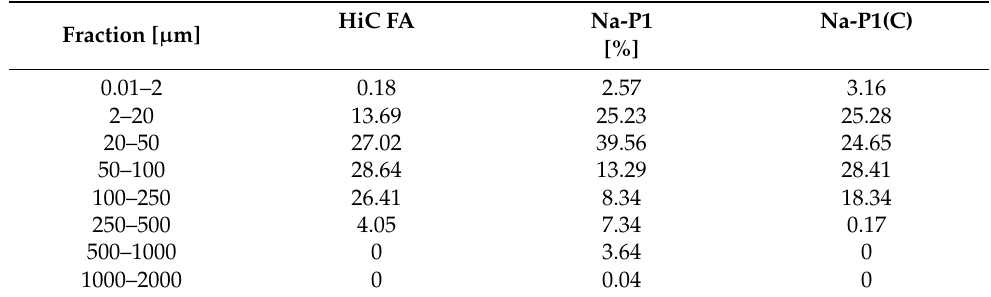
Table 2. Percentage distribution of individual grain fractions ( µ m) of HiC FA, Na-P1 and Na-P1(C). HiC FA Fraction [ µ m]